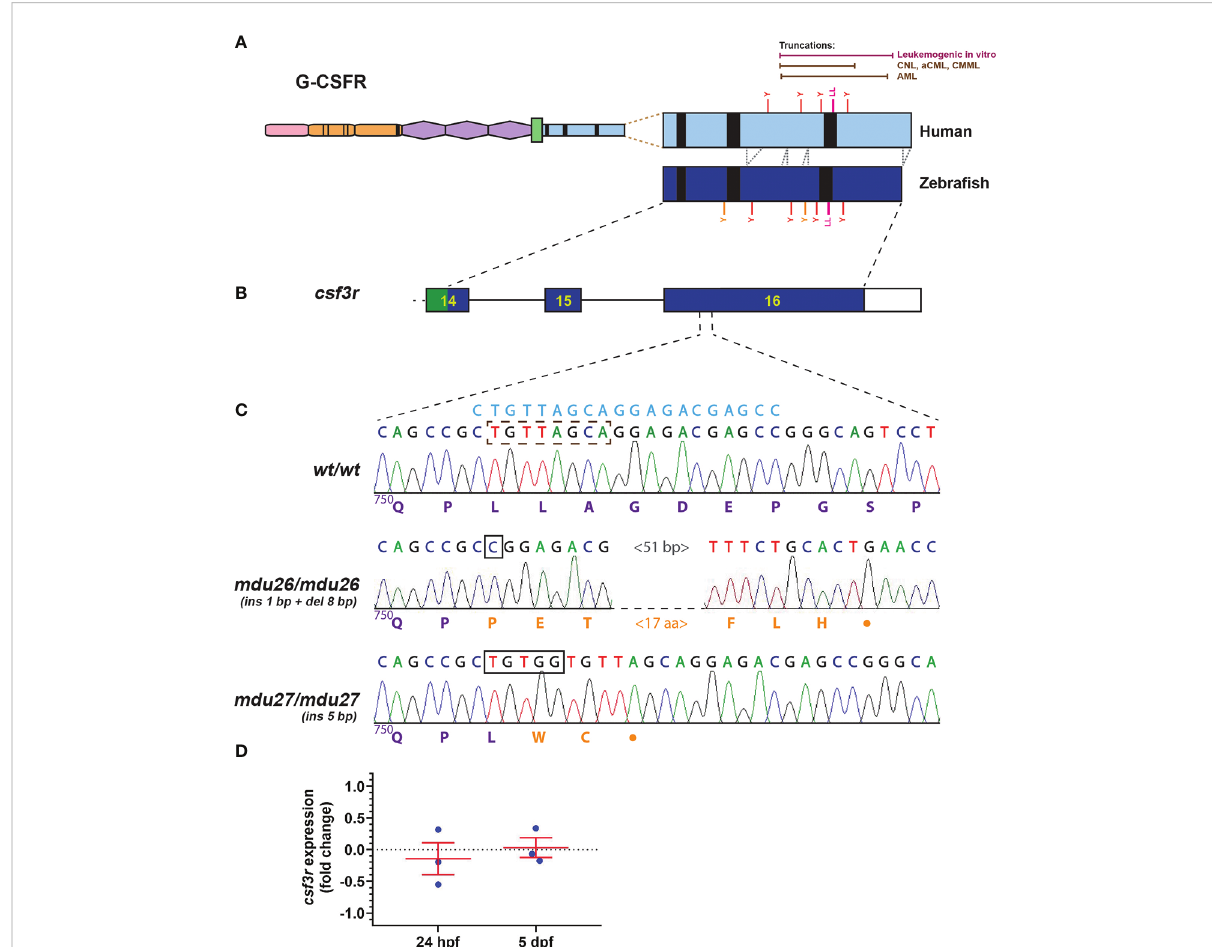
FIGURE 1 Generation of leukemia-derived G-CSFR truncation mutants. Schematic diagram of the G-CSFR showing the extracellular immunoglobulin domain (pink), cytokine receptor homology domain (orange) and fi bronectin type III-like domains (purple), transmembrane region (green), and intracellular region (blue) containing Box 1-3 (black rectangles). The intracellular region is expanded to show tyrosine (Y) residues and a di- leucine motif (LL) in both human and zebra fi sh proteins, with the relative positions of truncation mutations found in various human leukemias or demonstrated to be leukemogenic in vitro shown above (A) . Exons 14-16 of the zebra fi sh csf3r gene encoding the intracellular region presented as numbered boxes with connecting lines depicting introns (B) . Sequence traces of the indicated part of csf3r showing homozygous wild-type ( wt/wt ) and mutant zebra fi sh, with nucleotide sequence above and encoded protein sequences below, in purple for native and orange for de novo sequence (C) . The gRNA target site is shown above in blue, with deleted nucleotide sequences indicated with a brown dotted box and inserted sequences shown with black boxes. The csf3r mdu26 ( mdu26 ) allele represents a complex 1 bp insertion/8 bp deletion and the csf3r mdu27 ( mdu27 ) allele a 5 bp insertion both of which cause a frameshift resulting in translation from an alternative reading frame followed by a stop codon. Gene expression analysis of csf3r in pooled WT and mutant embryos at the indicated timepoints presented as fold-change (log 2 )